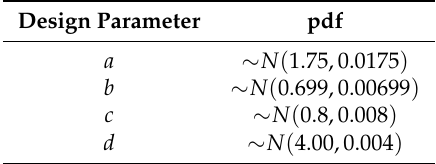
Figure 3. Assessment of UQ methods: approximate pdf of QoI J for MC, BK, and GEK. Table 2. Design parameters for the quasi-1D nozzle used for the assessment of the UQ techniques.